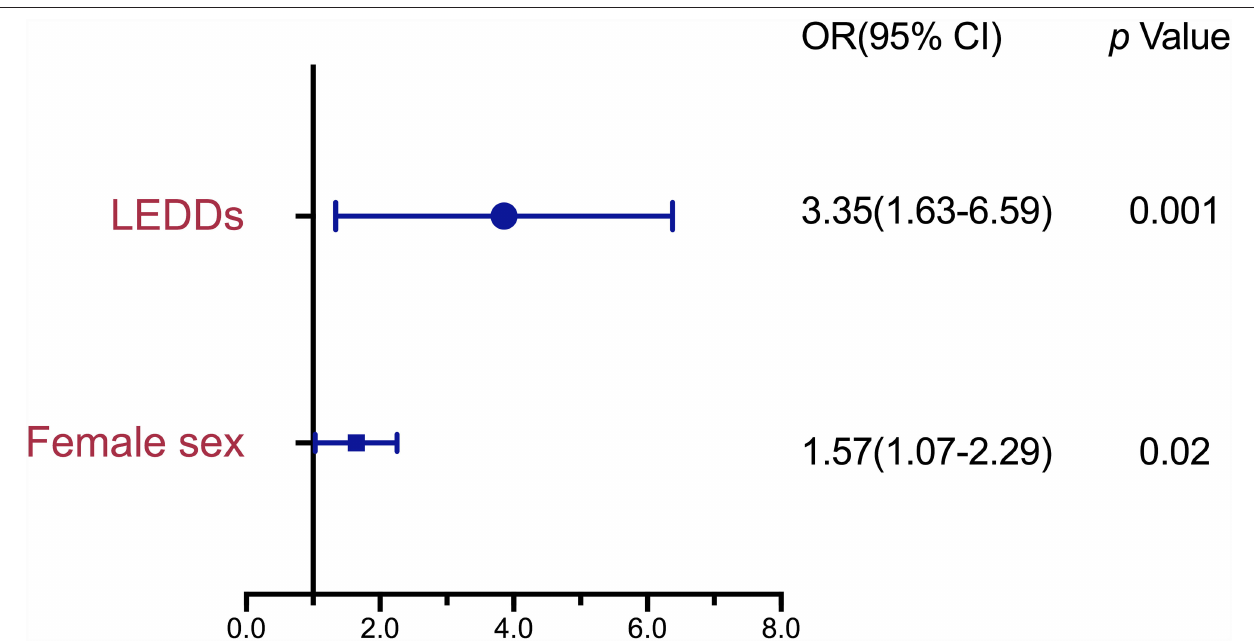
FIGURE 2 | Risk Factors associated with MSP in patients with Parkinson’s disease (PD) by binary logistic regression analysis. MSP, musculoskeletal pain; PD, Parkinson’s disease; OR, odds ratio; CI, confidence interval; LEDD, Levodopa-equivalent daily dose.